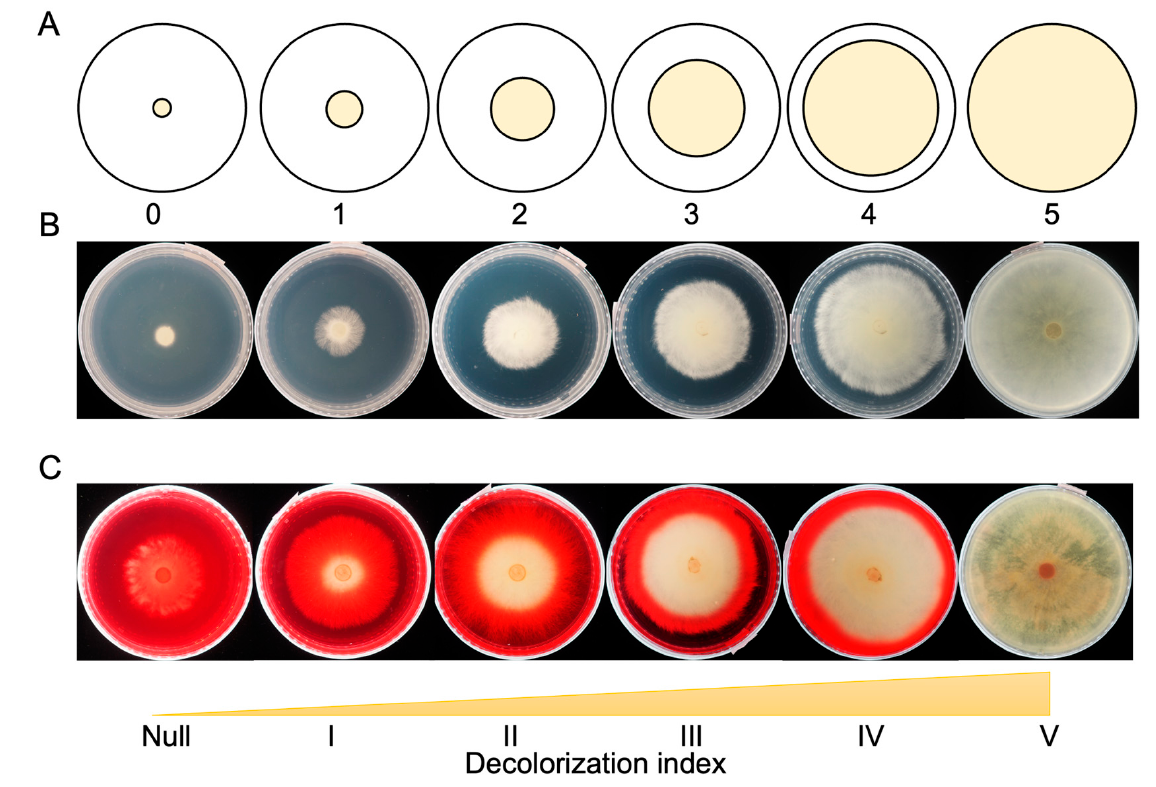
Figure 1. Measurement of fungal growth and dye-decolorization level. ( A ) A diagram of fungal mycelia growth index in the Petri dish. ( B ) Examples of PDA plates with growth indexes from zero to five. ( C ) Examples of PDA+DR5B plates with dye-decolorization indexes from null to V.